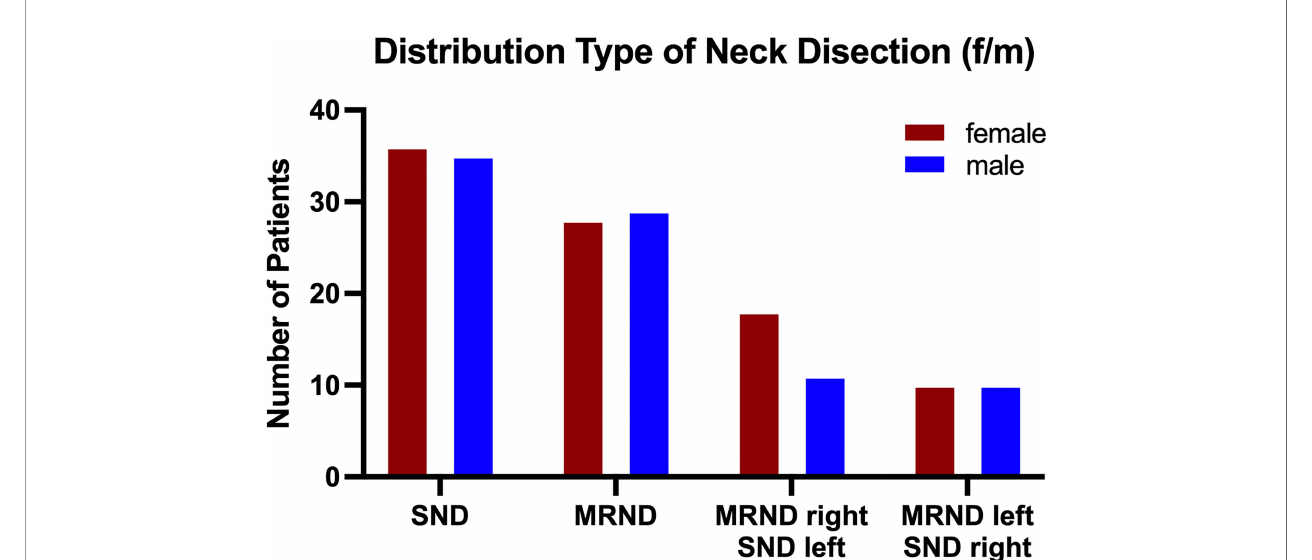
FIGURE 3 | Population distribution by type of neck dissection. Neck dissection was performed via 4 different de fi ned methods: (i) SND (I-IV) bilateral, (ii) MRND III (I-V) left/SND (I-IV) right, (iii) MRND III (I-V) right/SND (I-IV) left, and (iv) MRND III (I-V) bilateral. In 41.18% of all patients, SND bilateral was performed, followed by 34.12% dissected via MRND III, bilateral, 12.94% via MRND III, right/SND left, and 11.76% via MRND III, left/SND right. The gender distribution in all treatments was rather equal, except for MRND III, which was bilateral, with more male patients undergoing this treatment. Data are presented as total values, based on n=177 patients.